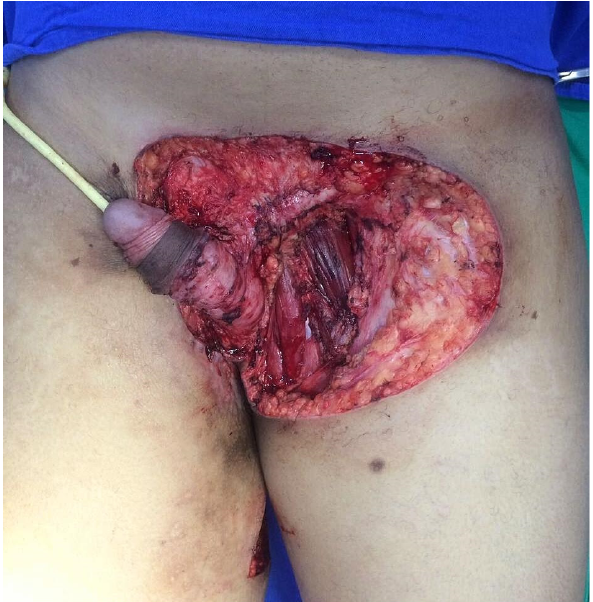
Figure 3. Aspect after resection of inguinal low grade fibromyxoid sarcoma involving the scrotum.